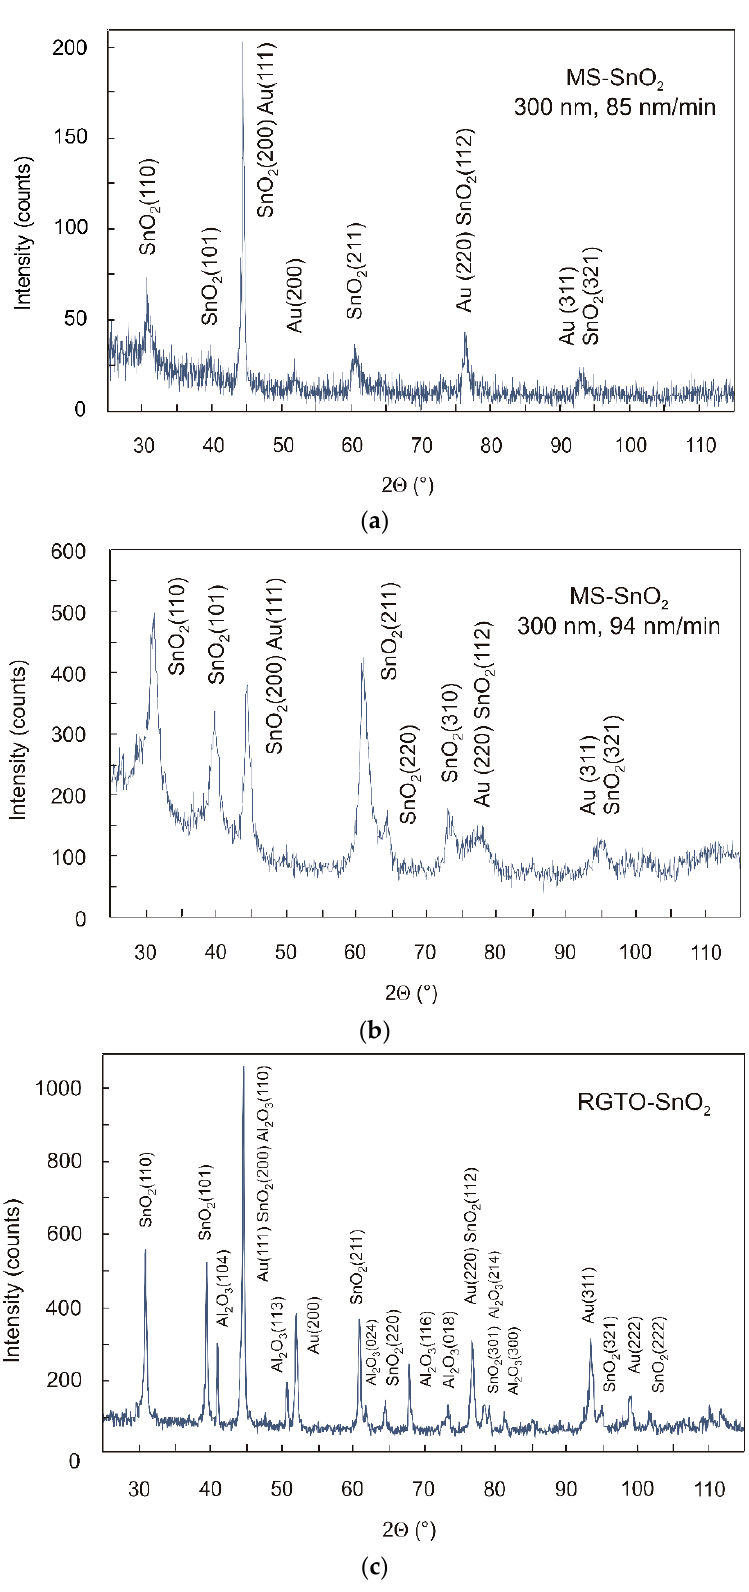
Figure 3. X-ray diffraction spectra for MS-SnO 2 300 nm thick film deposited on quartz substrate using magnetron sputtering with different deposition rate: ( a ) 85 nm/min and ( b ) 94 nm/min [48] and for ( c ) RGTO-SnO 2 film deposited on a ceramic substrate (Al 2 O 3 -96%) with a constant angle of incidence.